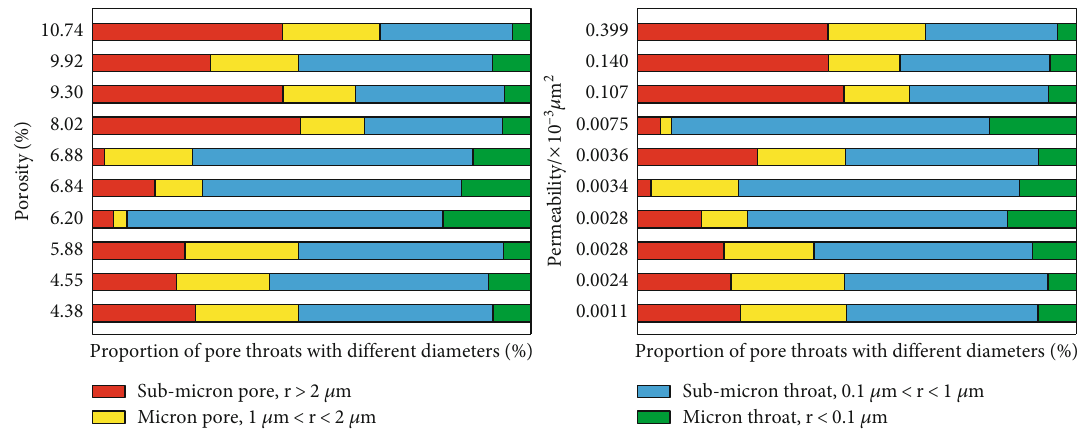
Figure 6: Relationship between pore with di ff erent aperture and reservoir